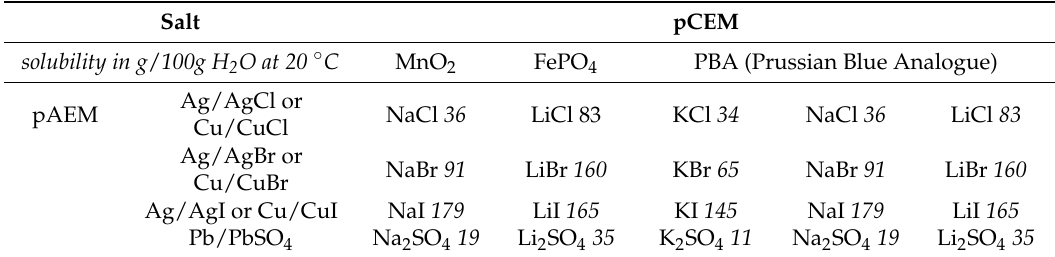
Table 5. Suggested systems, based on pseudo ion exchange membranes. The table shows 3 pCEMs (pseudo cation exchange membranes) in the columns and 7 pAEMs (pseudo anion exchange membrane) in the rows. On each intersection, the applicable salt and its solubility in g/100 g H 2 O at 20 ◦ C are listed